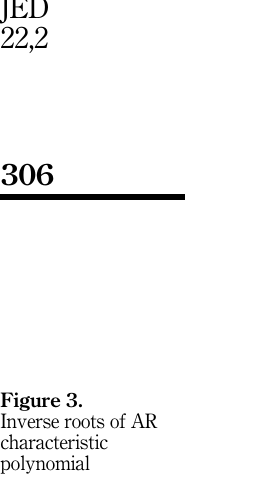
Figure 3. Inverse roots of AR characteristic